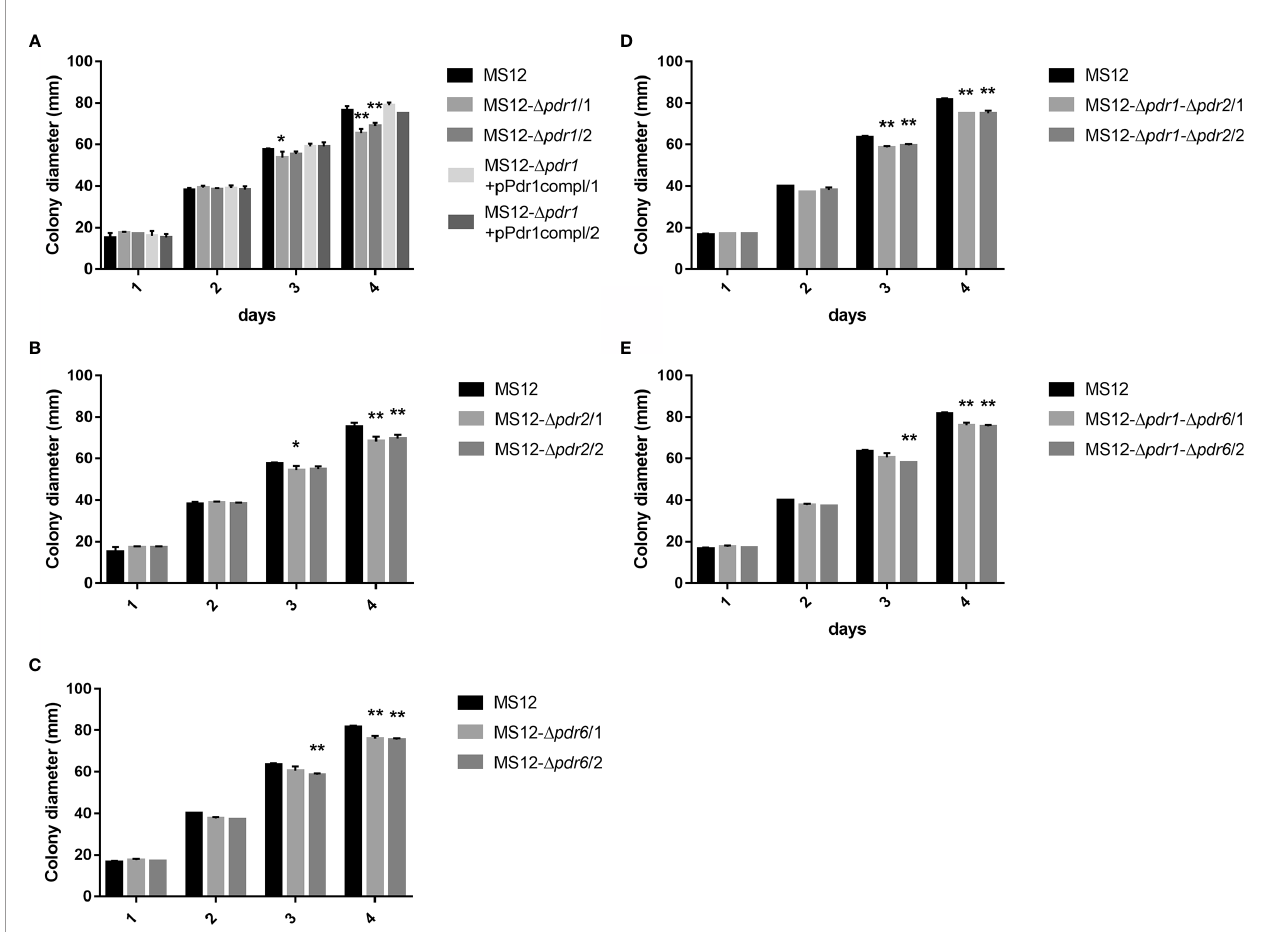
FIGURE 6 | Colony diameters of the pdr deletion mutants and the original MS12 strain of Mucor circinelloides at 25°C on YNB medium. (A) shows the colony diameter of pdr1 deleted and complemented strains, (B, C) show the colony diameter of the single pdr2 and pdr6 knock out mutants, while (D, E) show the colony diameter of the double knock out strains. The presented values are averages; colony diameters were measured during three independent cultivation (error bars indicate standard deviation). Values followed by * and ** signi fi cantly differed from the corresponding value of the MS12 strain according to the two-way Anova (* p < 0.05; ** p <